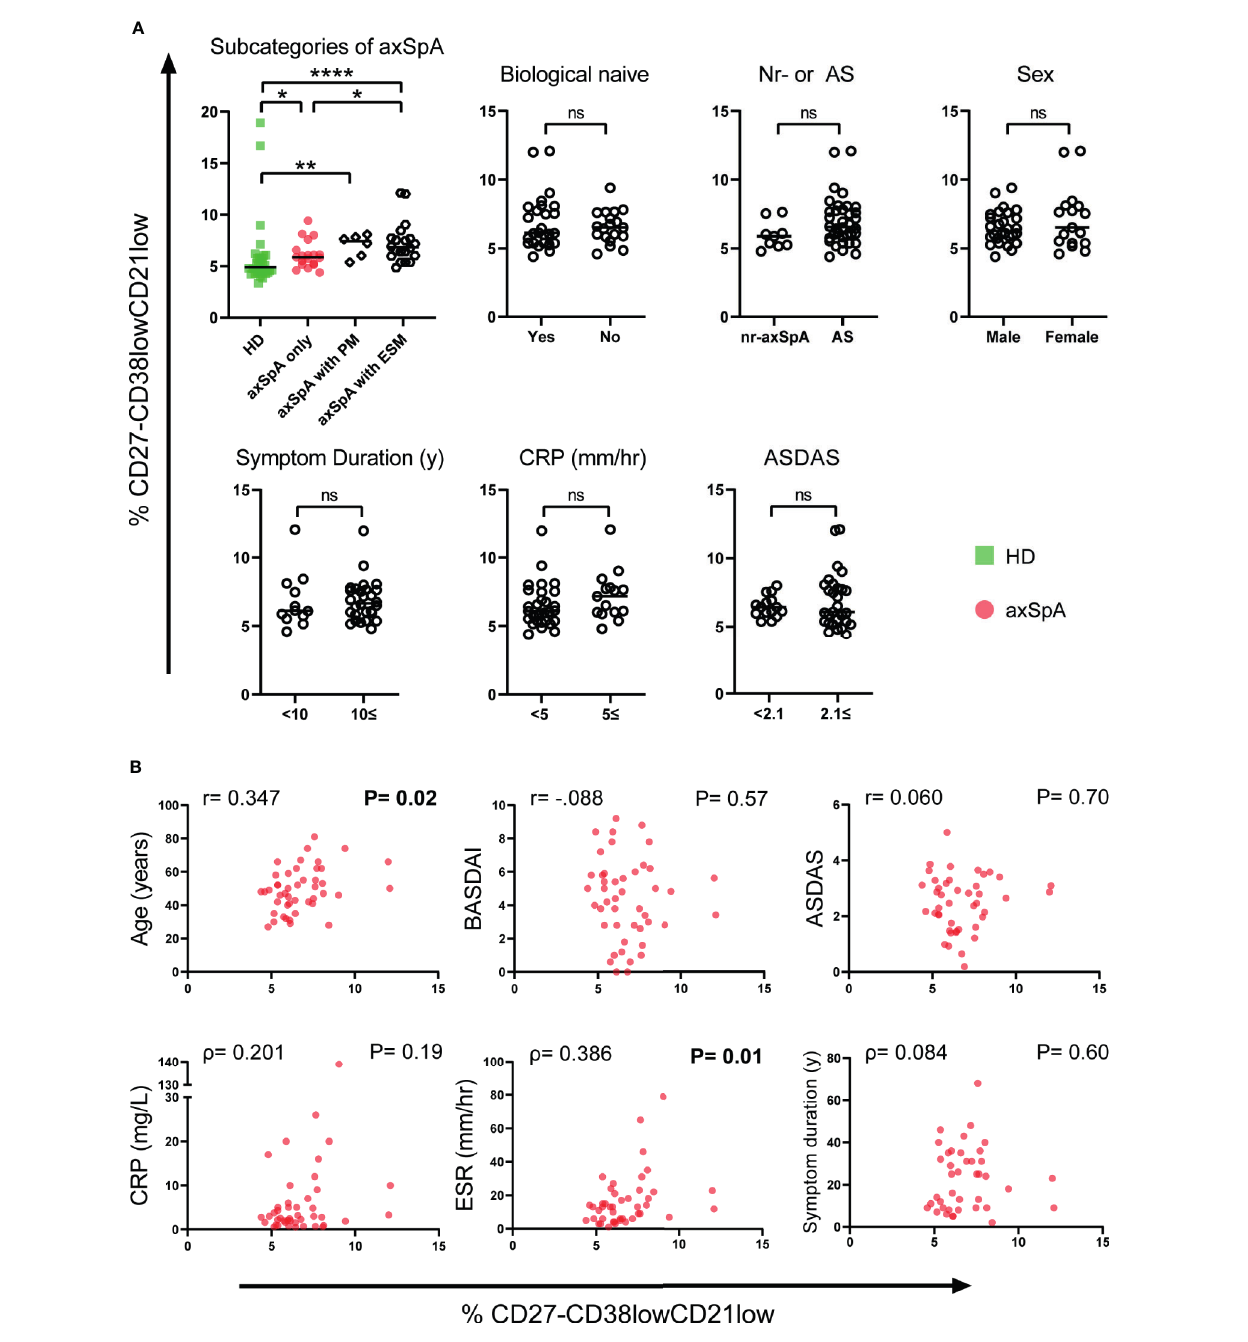
FIGURE 4 | Relationship between frequencies of CD27 - CD38 low CD21 low B-cells and clinical parameters in patients with axSpA. (A) Patients with axial spondyloarthritis (axSpA) were divided into separate groups based on subcategories of axSpA and the following clinical parameters: Biological DMARD naïve, nr- axSpA or axSpA, sex, symptom duration, C-reactive protein (CRP) and Ankylosing Spondylitis Disease Activity Score (ASDAS). (B) To explore associations between the CD27 - CD38 low CD21 low B-cell compartment and several continuous clinical parameters in patients with axSpA, the frequency of CD27 - CD38 low CD21 low B-cells was plotted against the following clinical parameters: Age, Bath Ankylosing Spondylitis Disease Activity Index (BASDAI), ASDAS, CRP, erythrocyte sedimentation rate (ESR), symptom duration. Patients with axSpA(n=45) are indicated with red circles, healthy donors (HD; n = 30) are indicated with green squares. *P < 0.05, **P < 0.01, ****P < 0.0001, signi fi cant values in bold, ns, not signi fi cant and horizontal lines indicate the